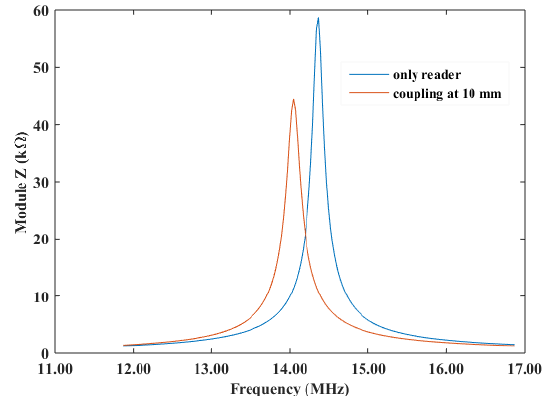
Figure 3. Module the reader and coupling between reader and wireless sensor at resonance